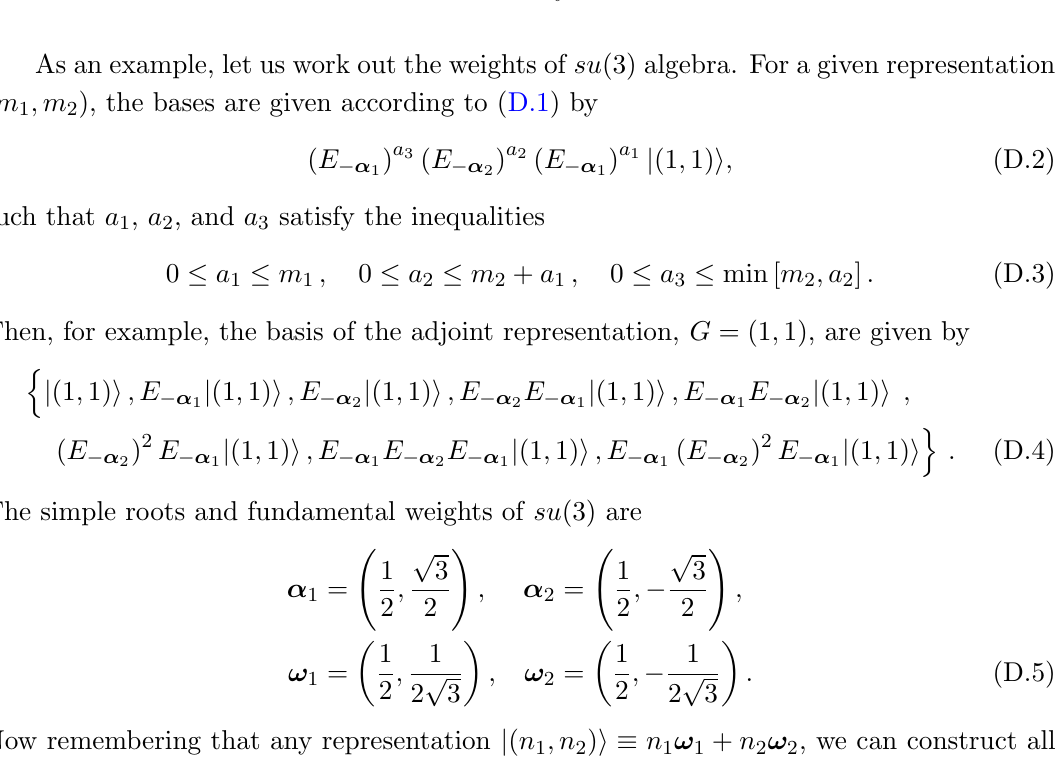
Table 10 . Cubic Dynkin